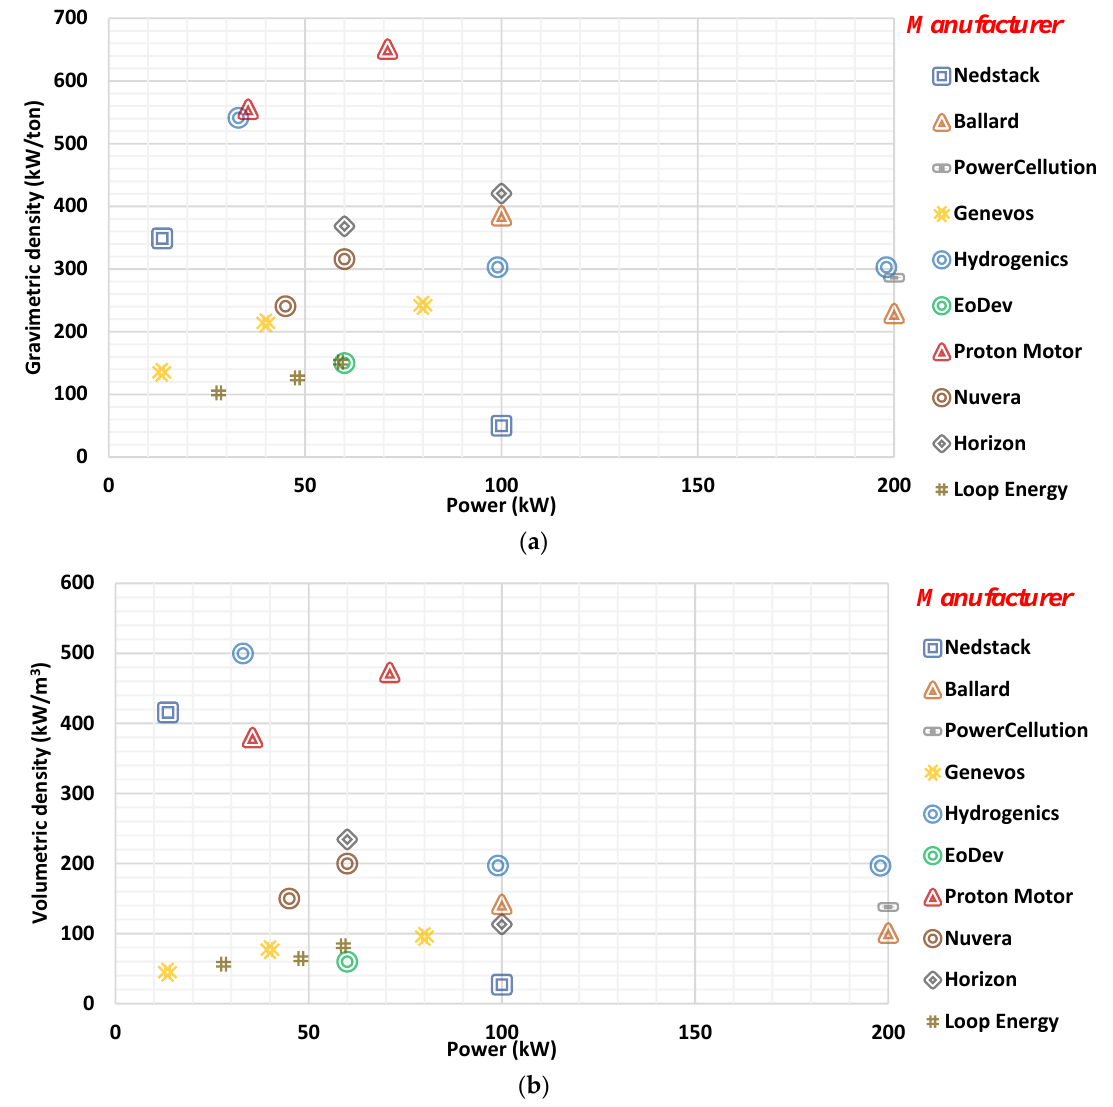
Figure 4. PEMFC products ( a ) Gravimetric power density ( b ) Volumetric power density.